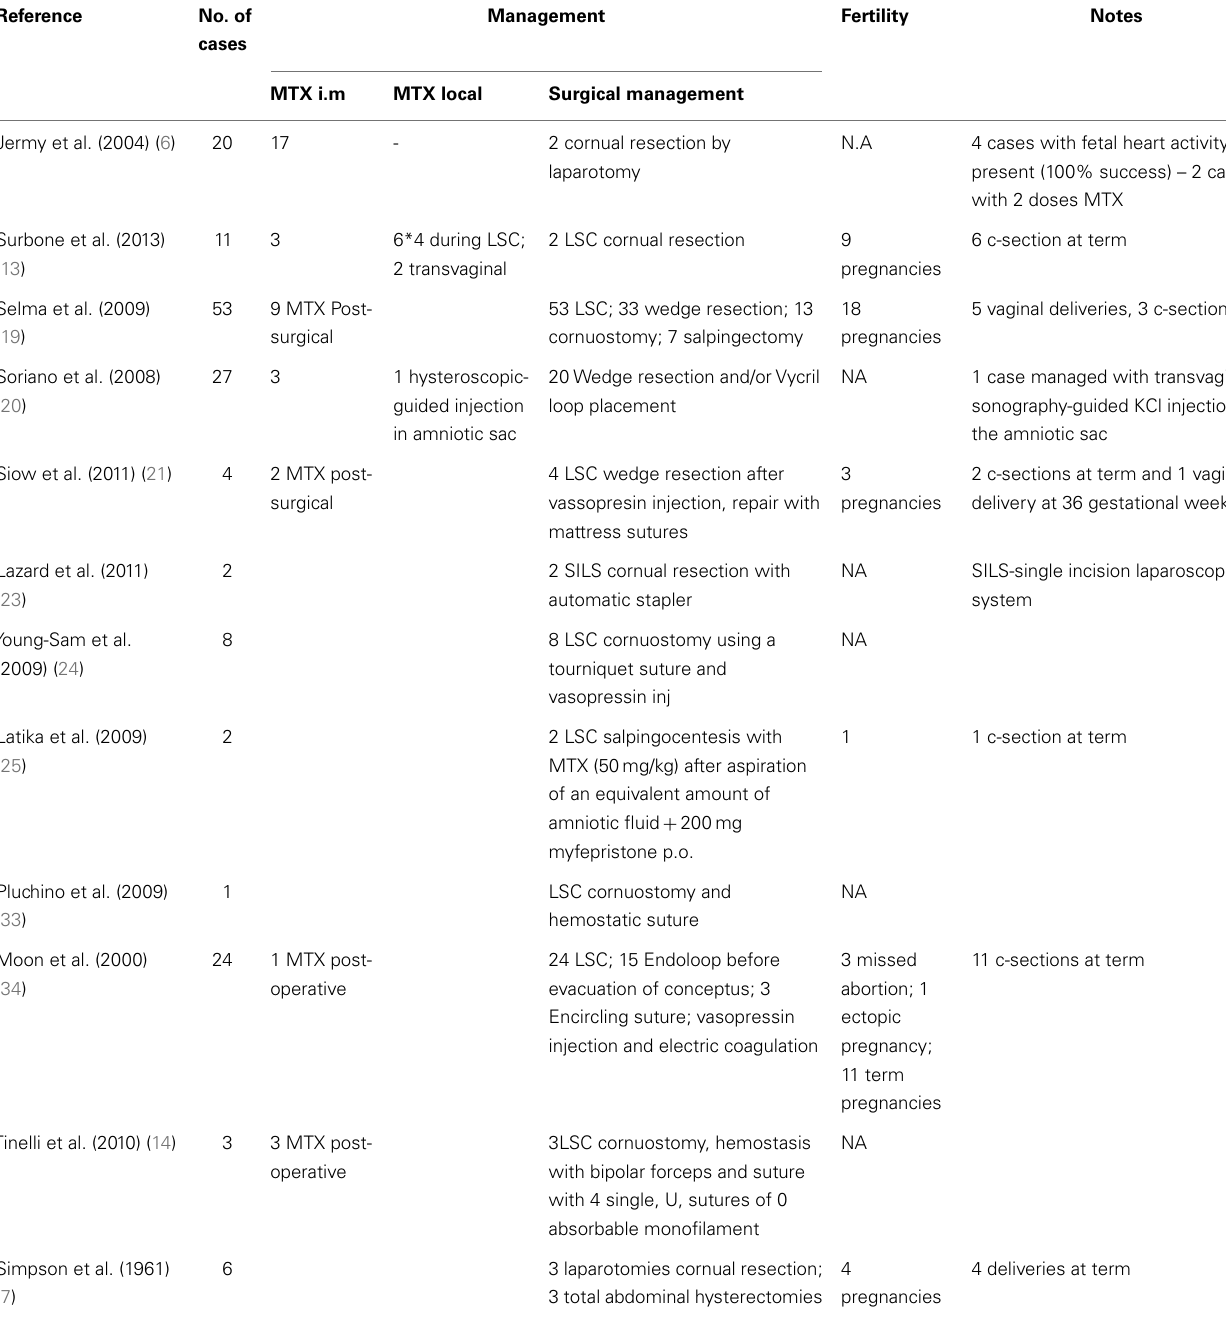
Table 1 | Reported interstitial pregnancy management and fertility outcome